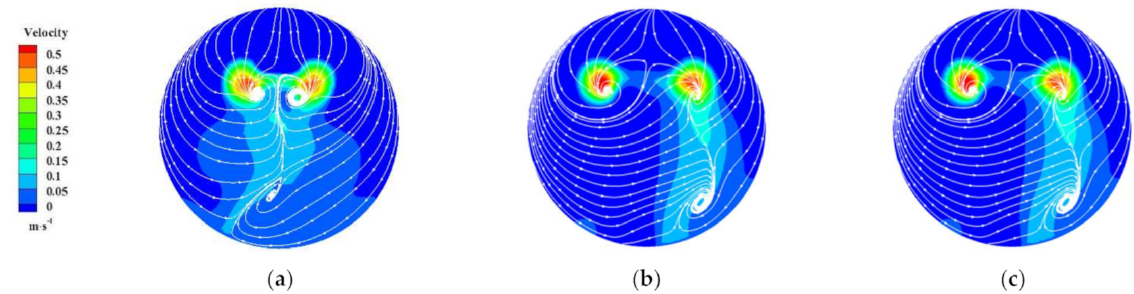
Figure 11. Streamline and velocity nephogram of Section 3-3 of the sump under different S values: ( a ) S = 0.6 R ; ( b ) S = 0.8 R ; ( c ) S = 1.0 R.